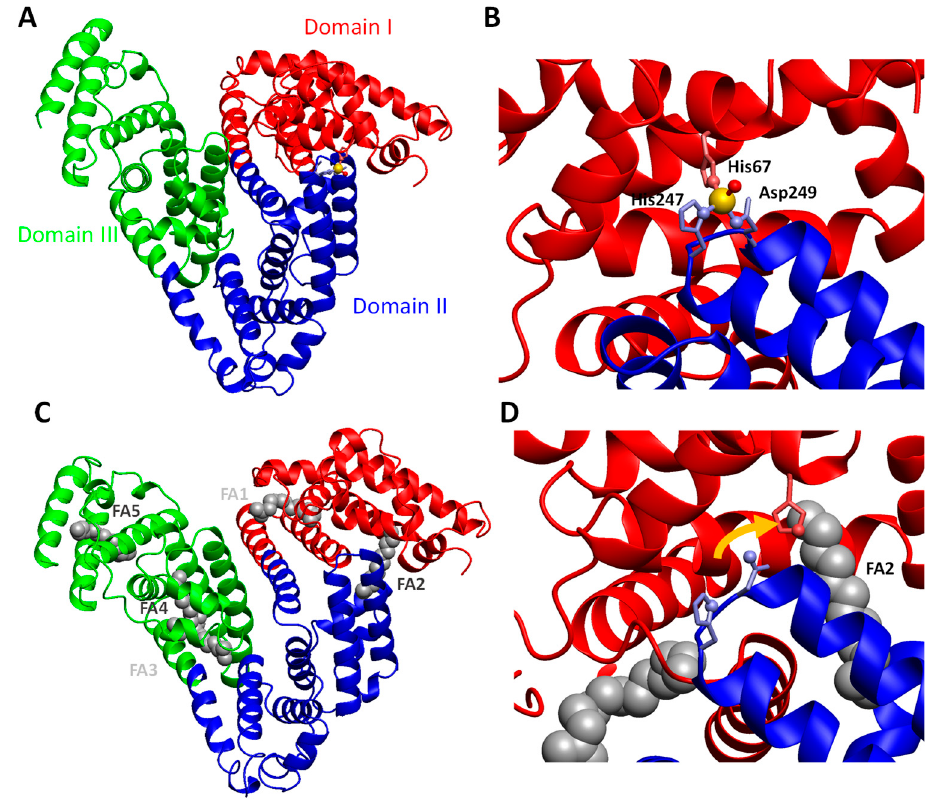
Figure 2. Structural aspects of zinc and FFA binding to HSA. ( A ) Domain structure and location of the major zinc binding site (golden sphere) on human serum albumin (pdb 5ijf; [83]). ( B ) Zinc is bound by three amino acid residues as indicated, with water as a fourth ligand. ( C ) Location of the five major FFA-binding sites on HSA as observed in presence of myristate (pdb 1bj5; [84]). FA2, 4 and 5 are high-affinity sites, whilst FA1 and FA3 are medium-affinity sites. Two further low-affinity sites are not occupied in this structure. ( D ) Disruption of the major zinc binding site by FFA binding to site FA2. His67 in domain I moves (as indicated by the orange arrow) by ca. 6 Å relative to His247 and Asp249 in domain II (see